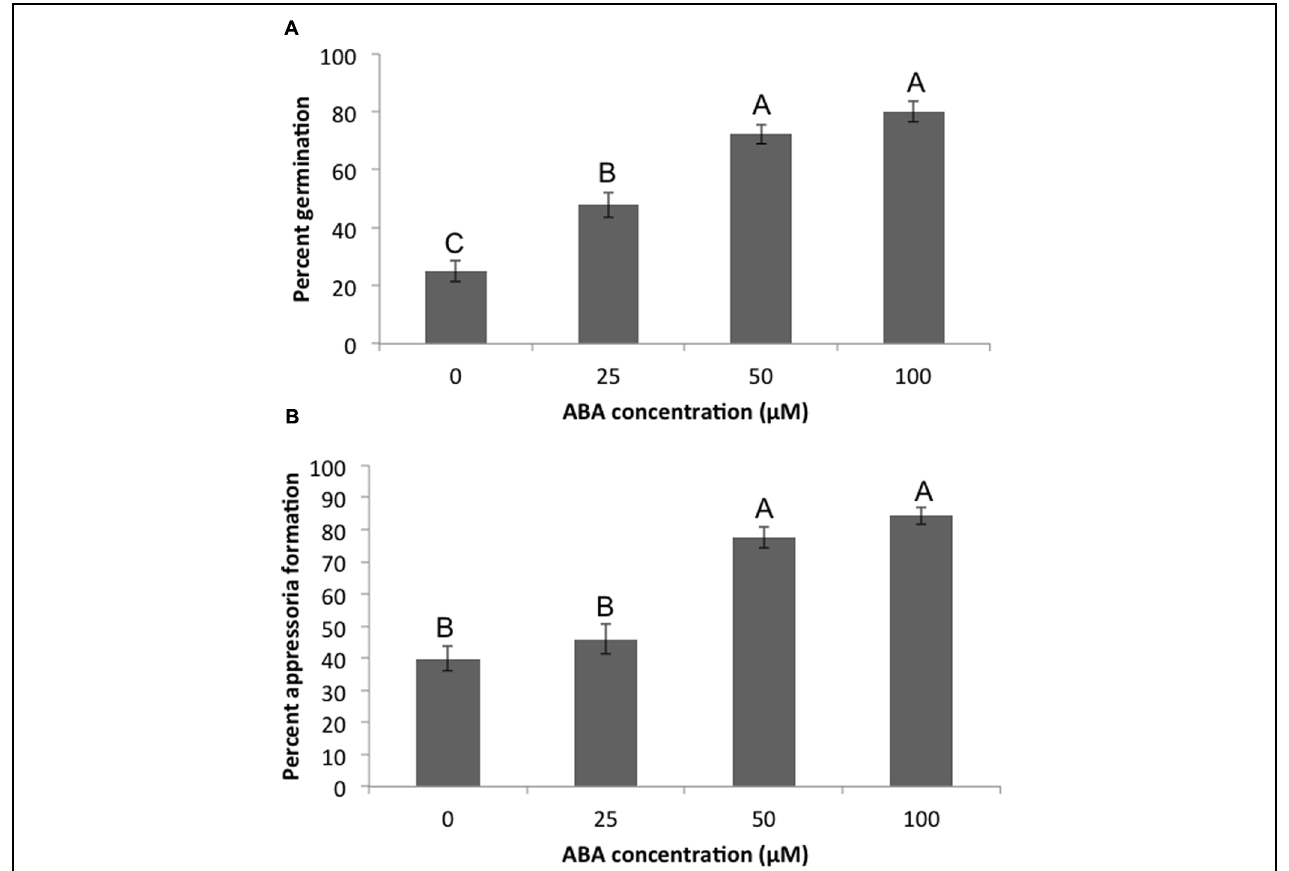
FIGURE 3 | Magnaporthe oryzae 70-15 spores treated with different concentrations of ABA. Images were taken at 2 and 6 h post-treatment and the percentage of spores (A) germinating or (B) forming appressoria were quantified. This experiment was repeated three times with five coverslips per treatment and three images per coverslip. Different letters represent statistical significance based on the Tukey-Kramer test ( p <